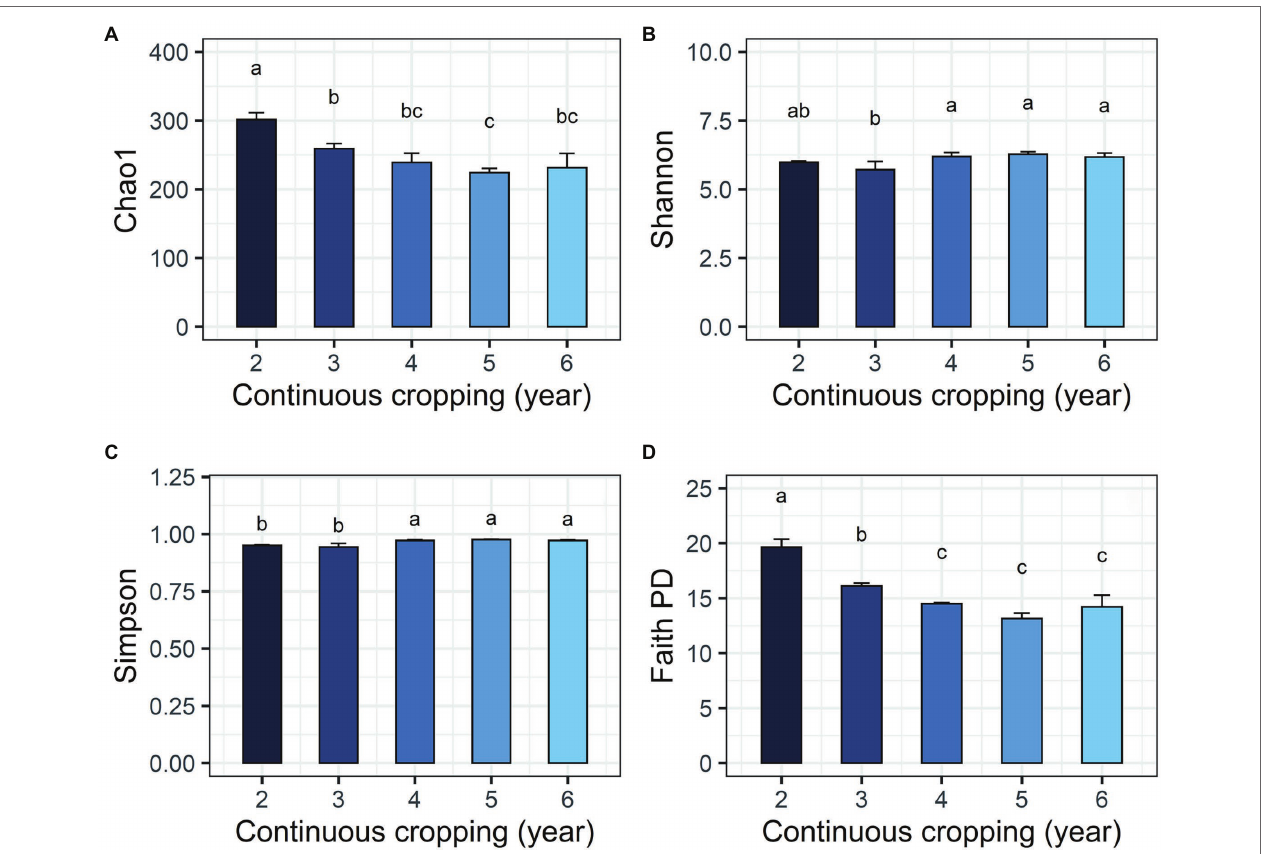
FIGURE 1 | Changes in alpha diversity indices of the fungal community during continuous cropping of Tibetan barley. (A) Chao1; (B) Shannon; (C) Simpson; (D) PD indices. Averages ± SD of samples in each group (with four biological replicates) are expressed in each column. Different letters within a row indicate significant differences at p <